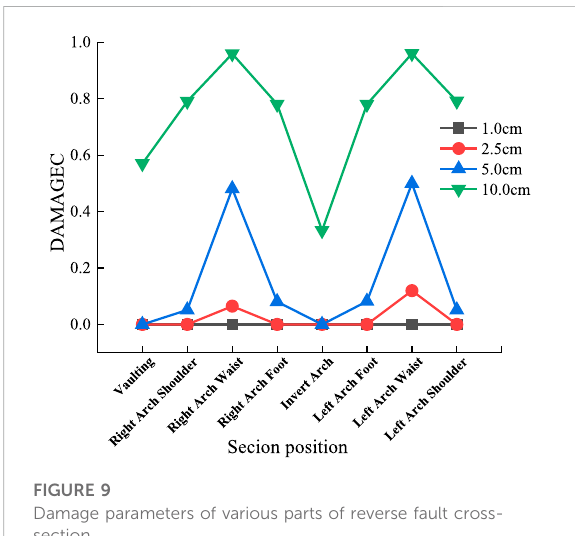
FIGURE 9 Damage parameters of various parts of reverse fault cross-